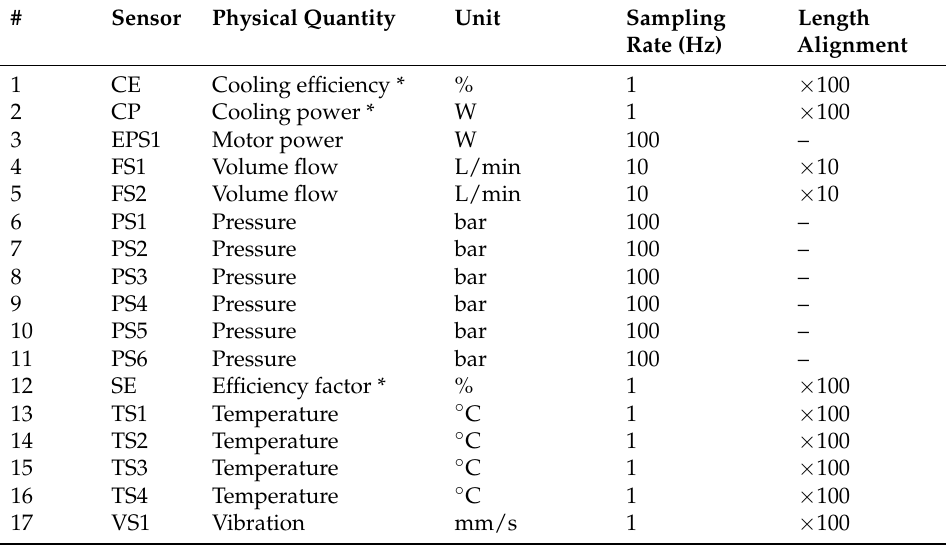
Table 1. Sensors of the dataset. * CE, CP and SE are virtual sensors.